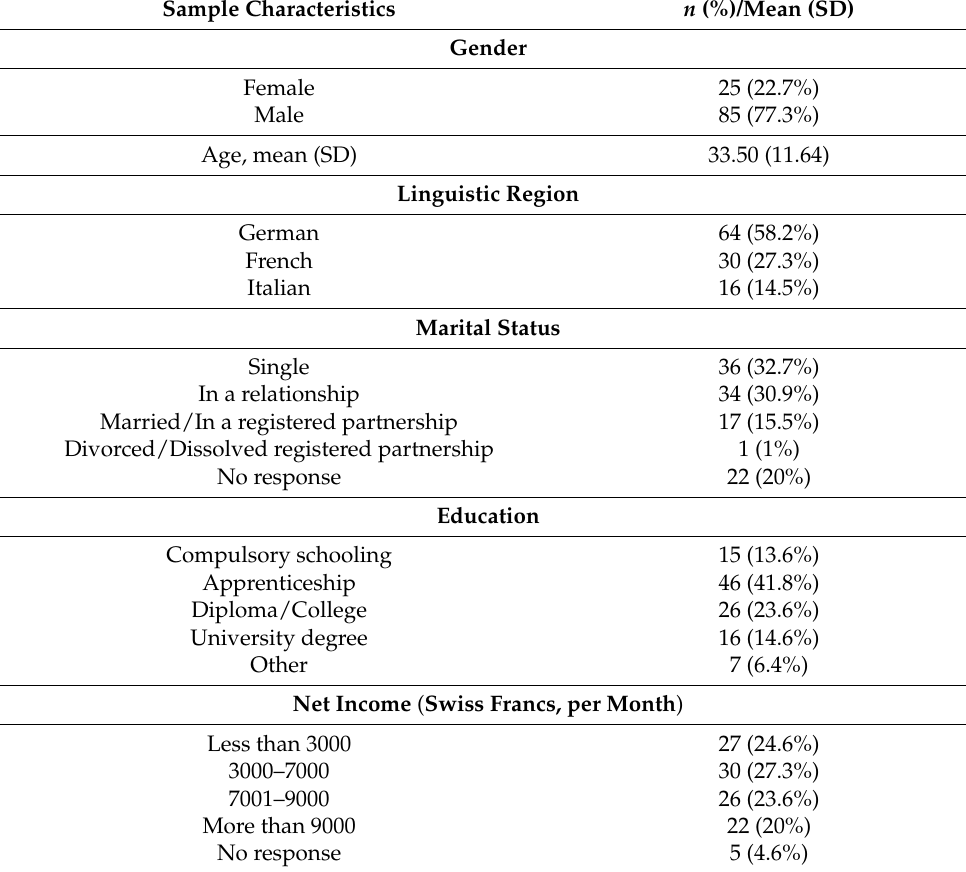
Table 1. Sample Characteristics Measured at T1 ( n =